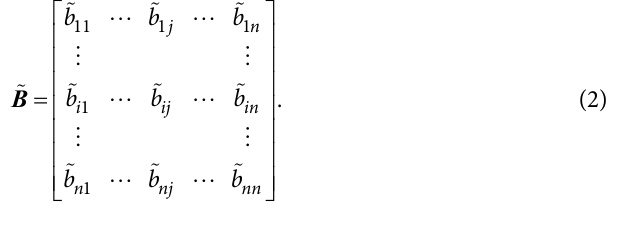
Table 1. Membership functions for FDEMATEL questionnaire (example) Linguistic scales of fuzzy number ( ij b  ) Corresponding triangular fuzzy numbers (